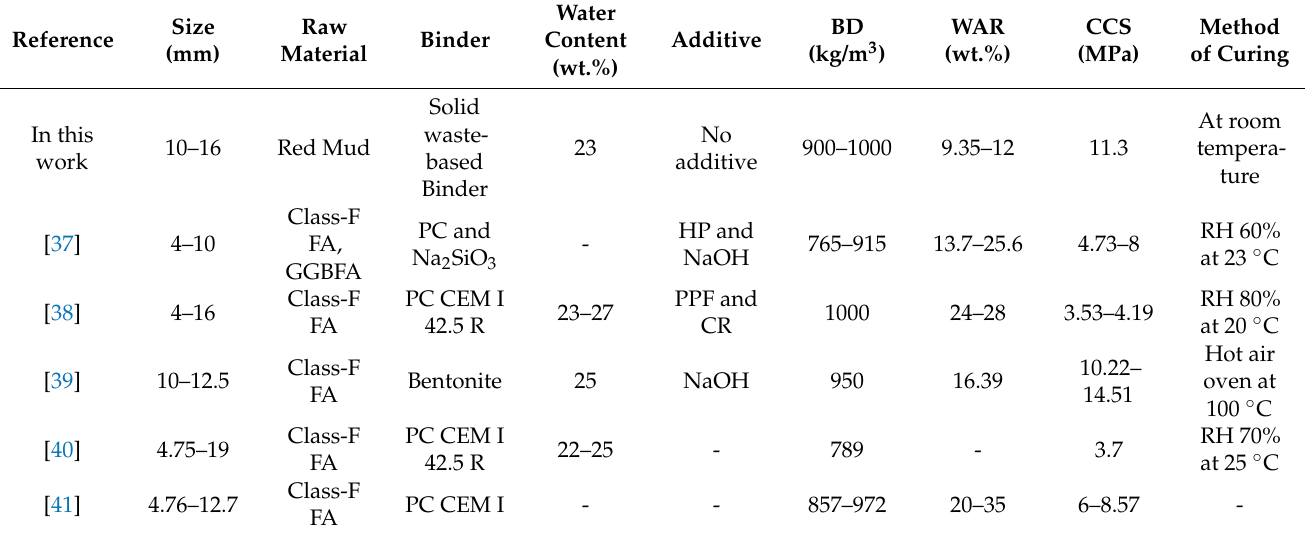
Table 9. Physical properties of RM-based SFLAs and conventional lightweight aggregates